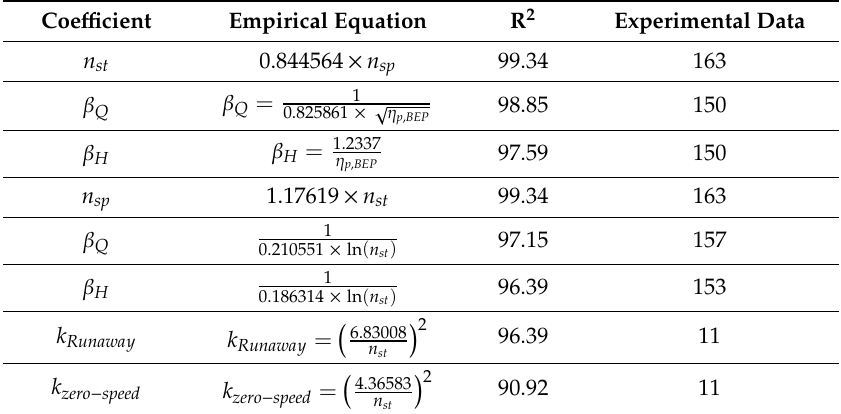
Table 3. Proposed empirical relationship to define the best e ffi ciency point of the machine as a function of the specific